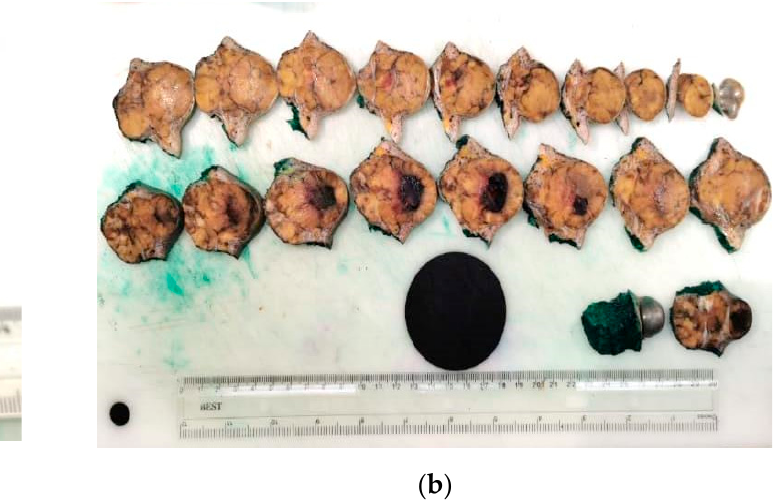
Figure 14. In-transit metastasis. ( a ) Gross examination. ( b ) Gross examination, cut section. We observed a well-defined nodule in the dermis and subcutaneous fat. (Collection of Pathology Department SCJ Mure ș ).